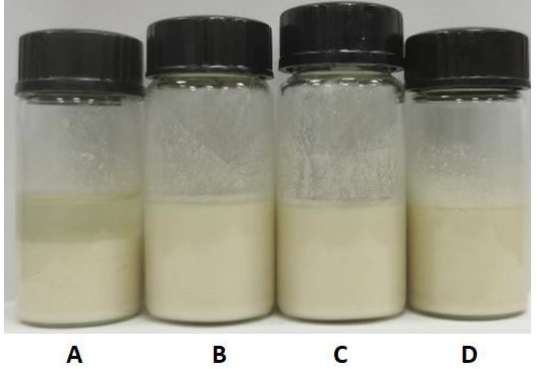
Figure 5. The appearance of the nanosuspension prepared by different stabilizers. ( A ): PVP, ( B ): PVA, ( C ): Tween 80; ( D ): HEL-40 as